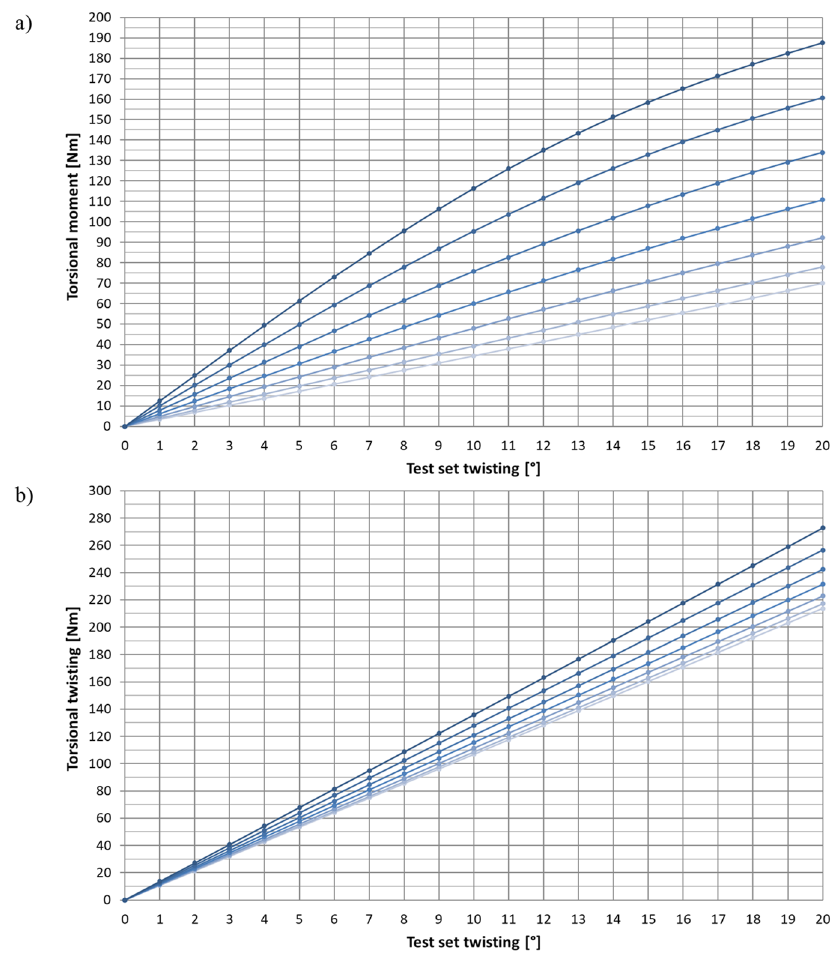
Figure 6. Change in the torsional moment of the 3 × 60 and 6 × 30 test sets during the numerical twisting test. The following expansions are marked with colors from the lightest to the darkest: 0, 5, 10, 15, 20, 25, and 30 mm. ( a ) 3 × 60 package. ( b ) 6 × 30